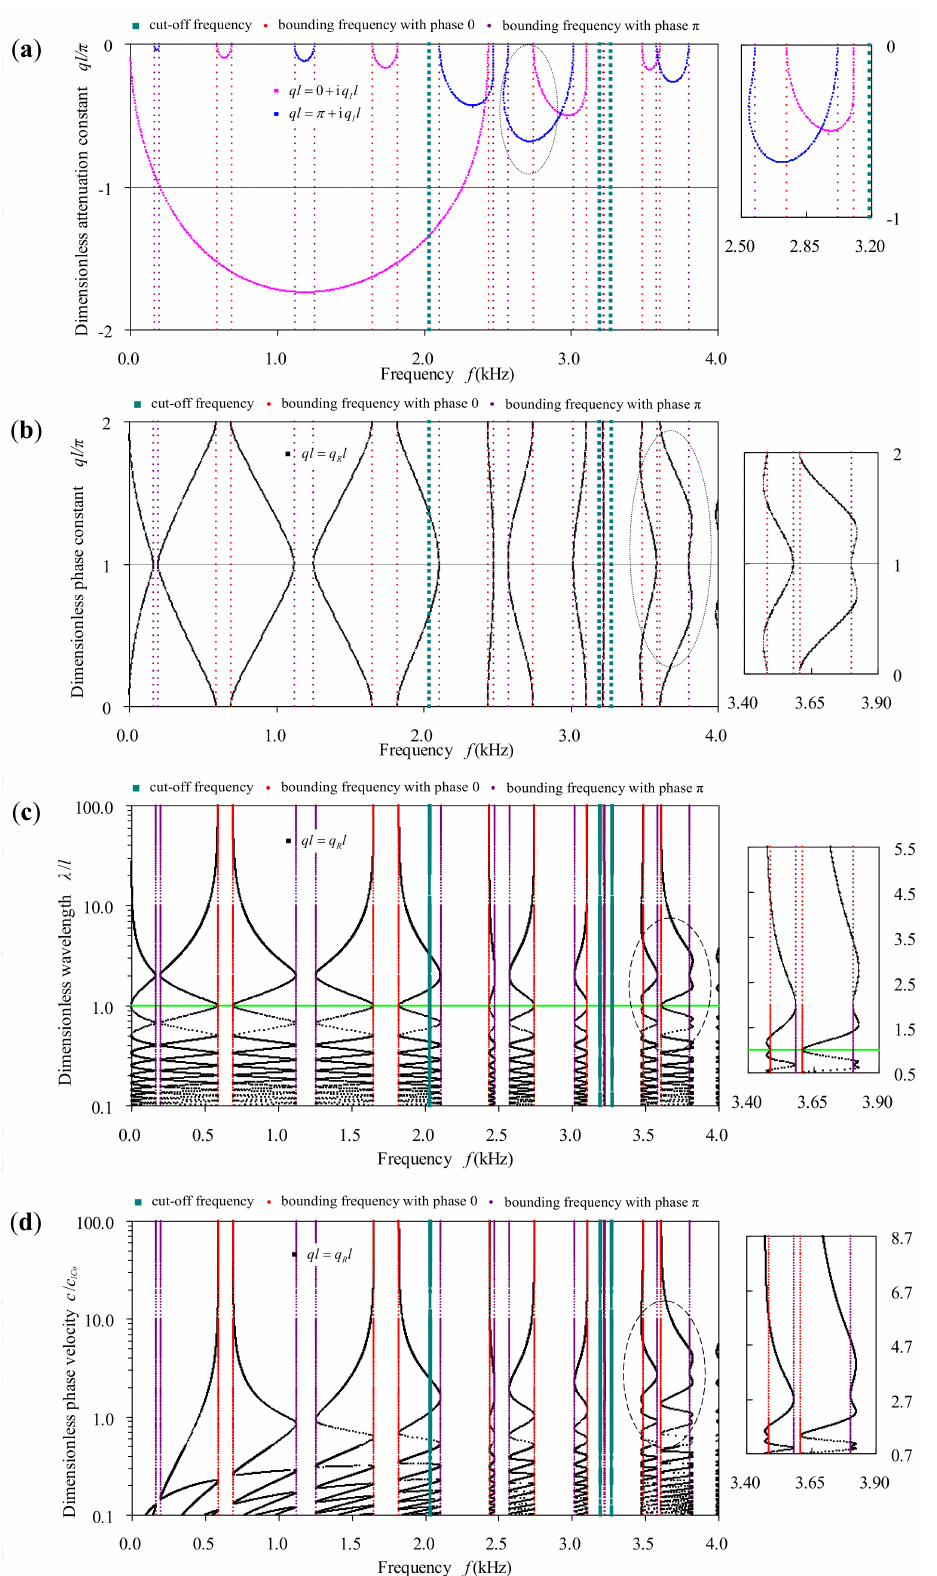
Figure 6. Frequency-related dispersion curves of bending waves in the bi-coupled periodic beam with Ternary-I unit cell: ( a ) the attenuation constant spectra; ( b ) the phase constant spectra; ( c ) the wavelength spectra; ( d ) the phase velocity